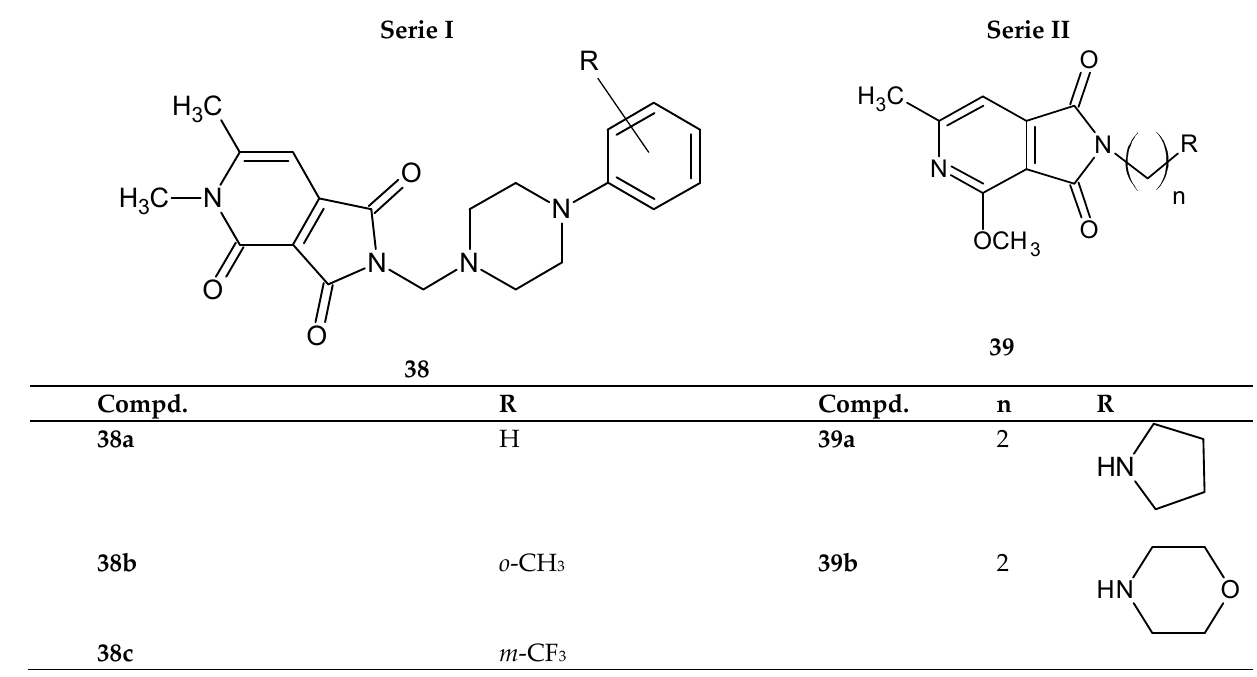
Figure 30. Derivatives of 1 H ‐ pyrrolo[3,4 ‐ c ]pyridine ‐ 1,3(2 H ) ‐ diones 38 and 39 .